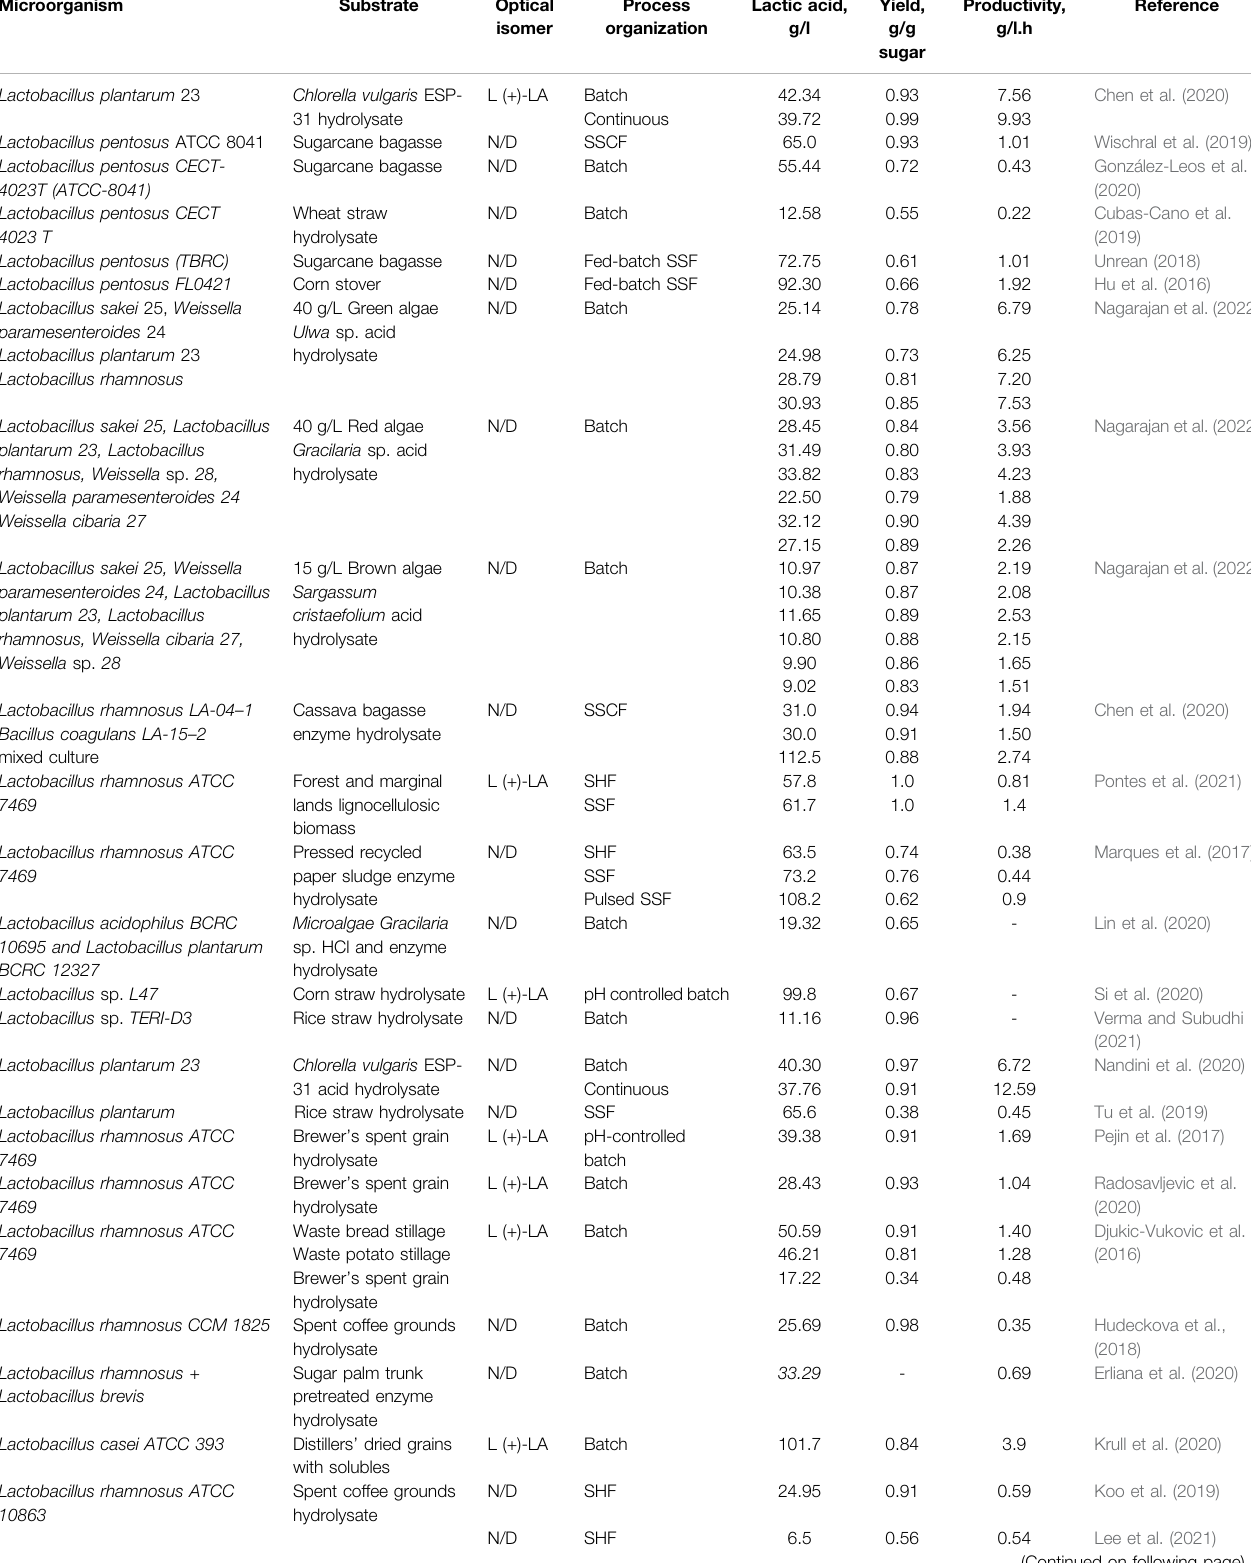
TABLE 4 | Microorganisms, substrates, and lactic acid yield and productivity from different feedstocks.